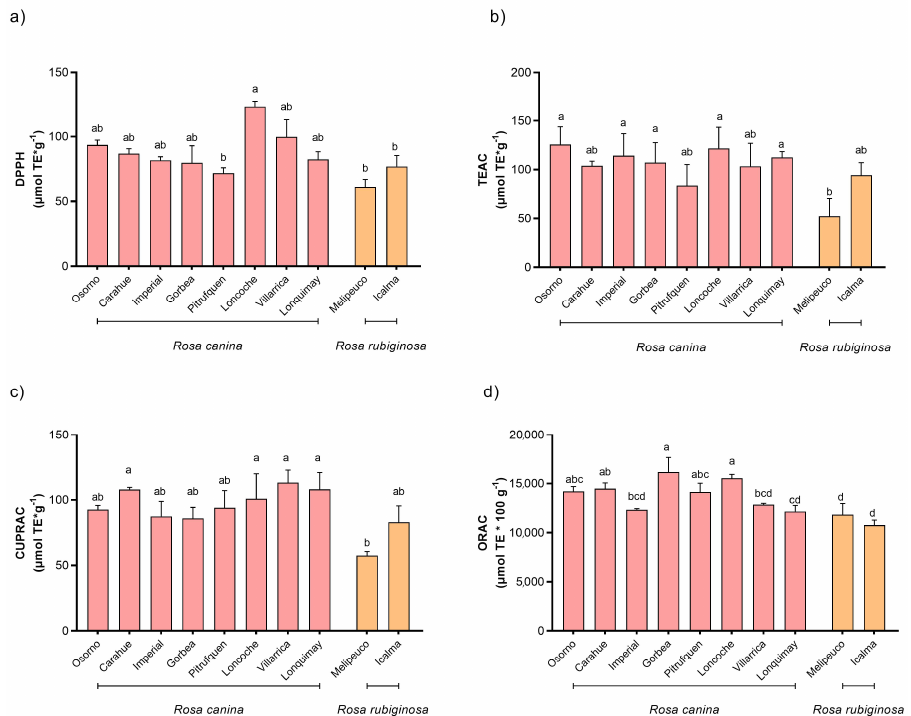
Figure 2. Antioxidant activity by spectrophotometric methods: ( a ) 2,2-diphenyl radical method (DPPH); ( b ) Trolox equivalent antioxidant capacity (TEAC); ( c ) cupric reducing antioxidant capacity (CUPRAC); ( d ) Oxygen Radical Antioxidant Capacity (ORAC). Concentrations were expressed as fresh weight (FW). Different letters in each sub-figure indicate the presence of statistically significant differences according to the Tukey’s multiple range test ( p ≤ 0.05; n = 9).